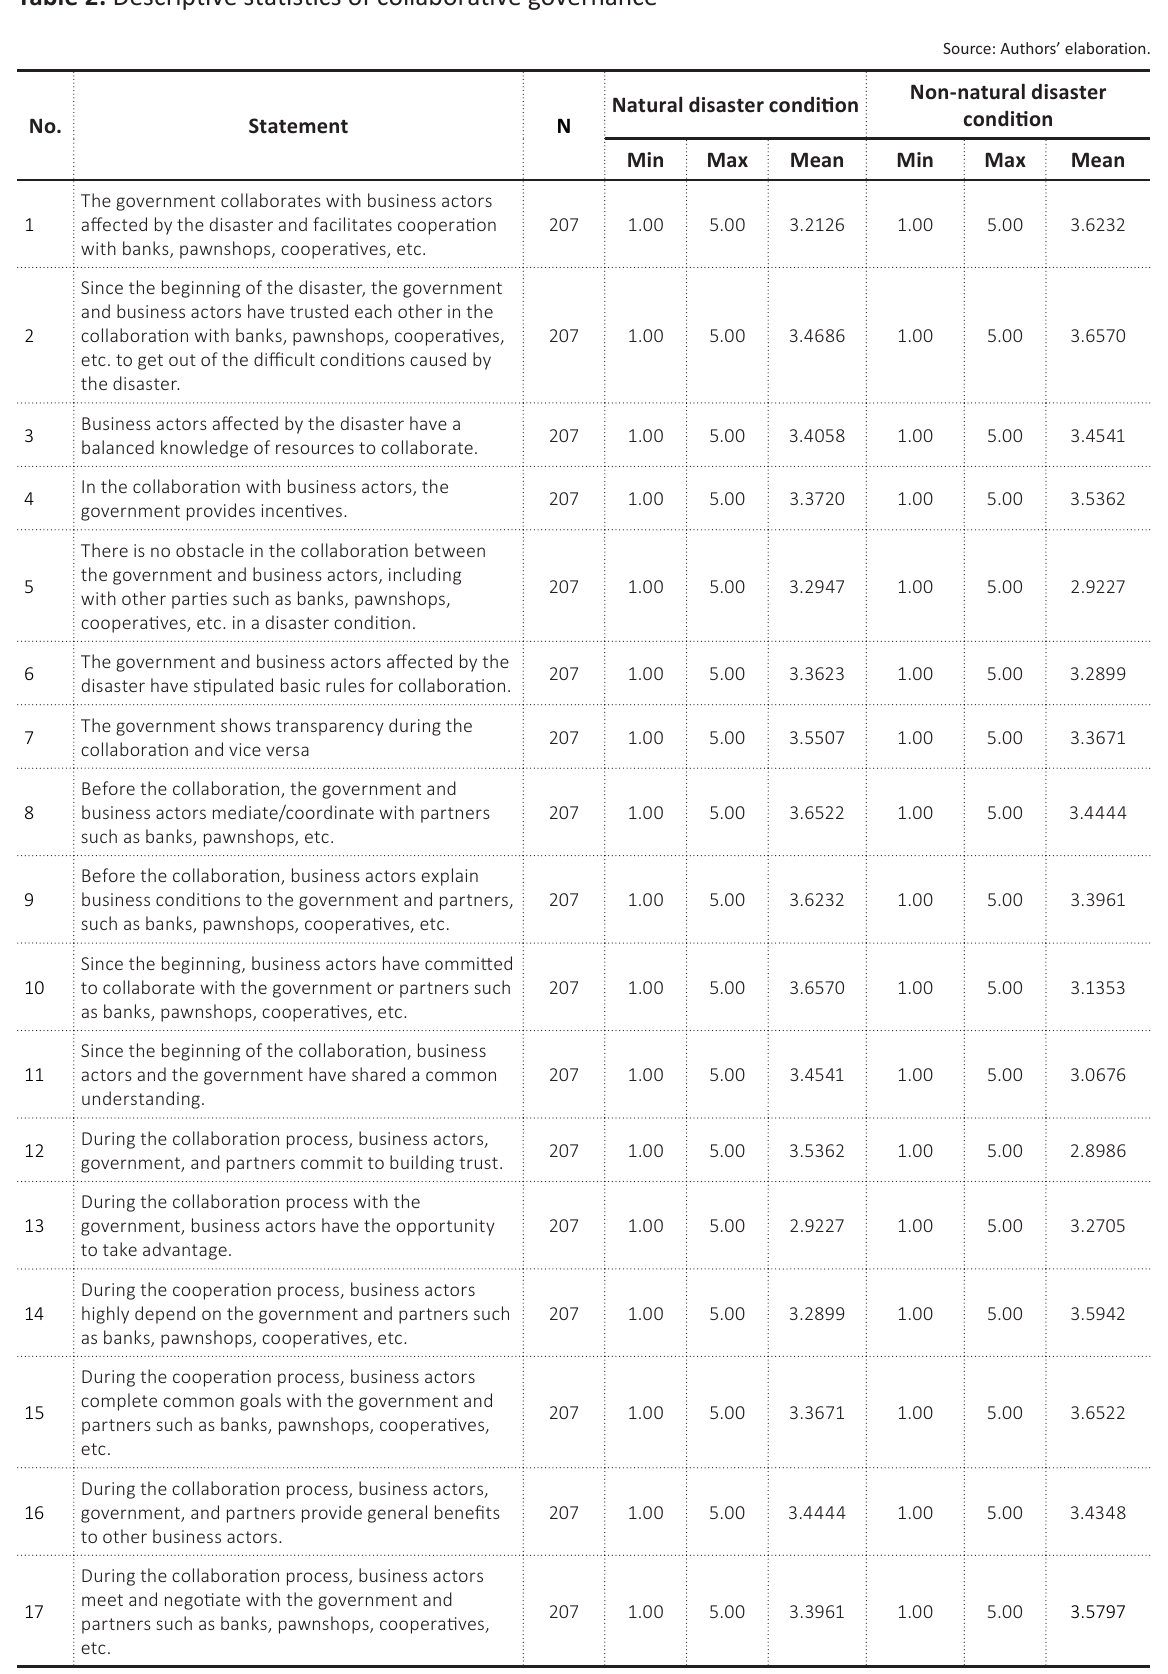
Table 2. Descriptive statistics of collaborative governance